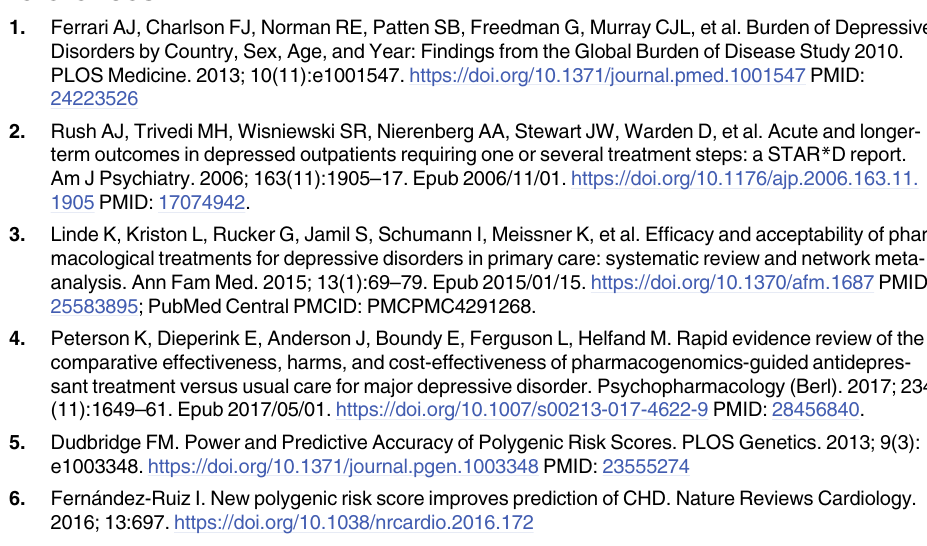
S3 Fig. Neuroticism PRS meta-analysis results at 4 weeks A) p < 5 (cid:3) 10 − 8 , B) p < 5 (cid:3) 10 − 5 , C) p < 0.01, D) p < 0.05, E) p < 0.1, F) p < 0.5. (TIF) S4 Fig. Neuroticism PRS meta-analysis results at 8 weeks A) p < 5 (cid:3) 10 − 8 , B) p < 5 (cid:3) 10 − 5 , C) p < 0.01, D) p < 0.05, E) p < 0.1, F) p < 0.5.